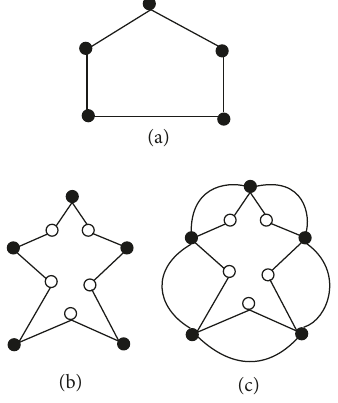
Figure 1: (a) Q , (b) S